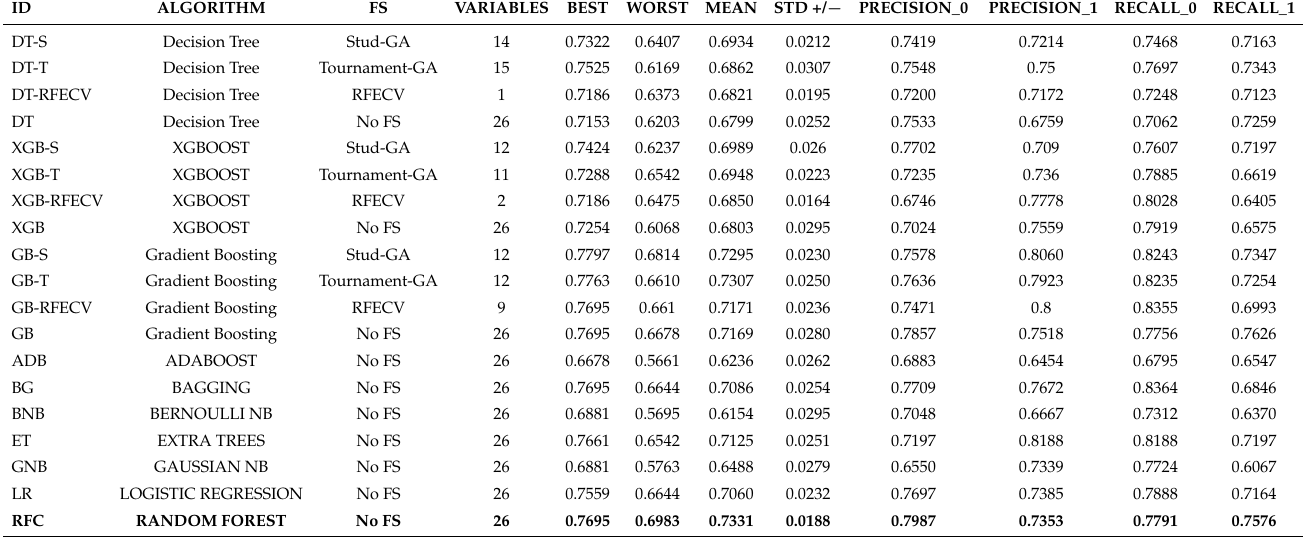
Table 3. Results of the different algorithms for the set of variables without pathologies. The table shows the algorithm, selection method, number of variables used, best case, worst case, mean, and standard deviation. The algorithm with the highest mean is marked with bold